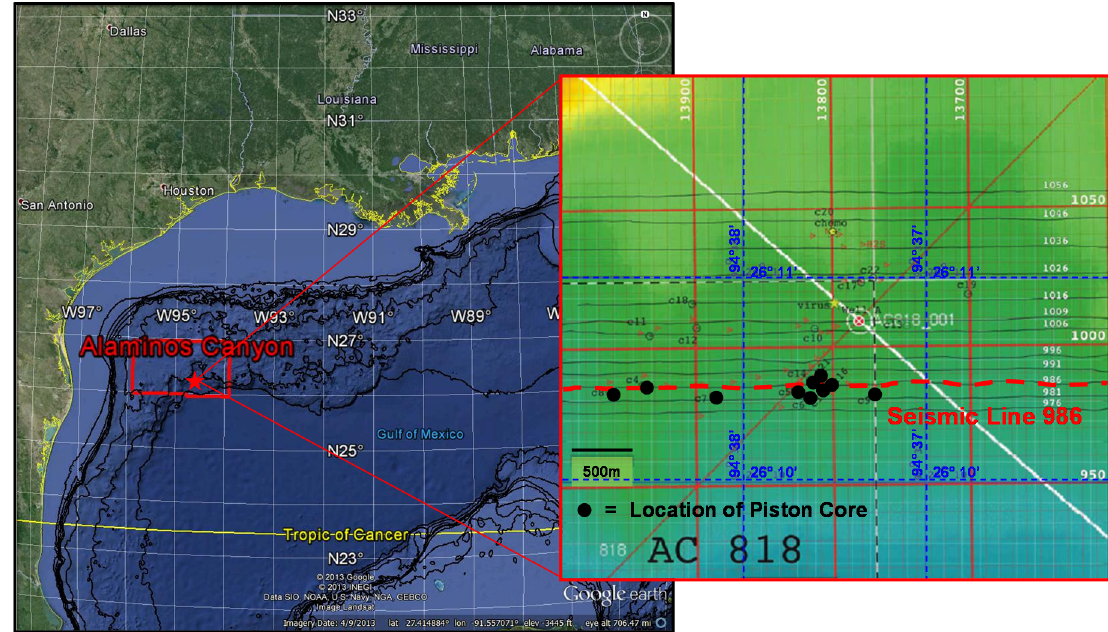
Figure 1. Map showing the location of Alaminos Canyon (AC) in the Gulf of Mexico (GoM). Inlet shows detail of survey block AC 818 containing seismic line 986 (dashed line). Black dots indicate locations of piston cores collected by the U.S. Naval Research Laboratory (NRL) as part of the AC-07 methane hydrate research expedition, June 2007 (Map modified from Google Earth using data from U.S. Geological Survey (USGS), National Archive of Marine Seismic Surveys; Texas A&M University, Gulf of Mexico Coastal Ocean Observing System (GCOOS), Coastal Relief Model for the Gulf of Mexico; and